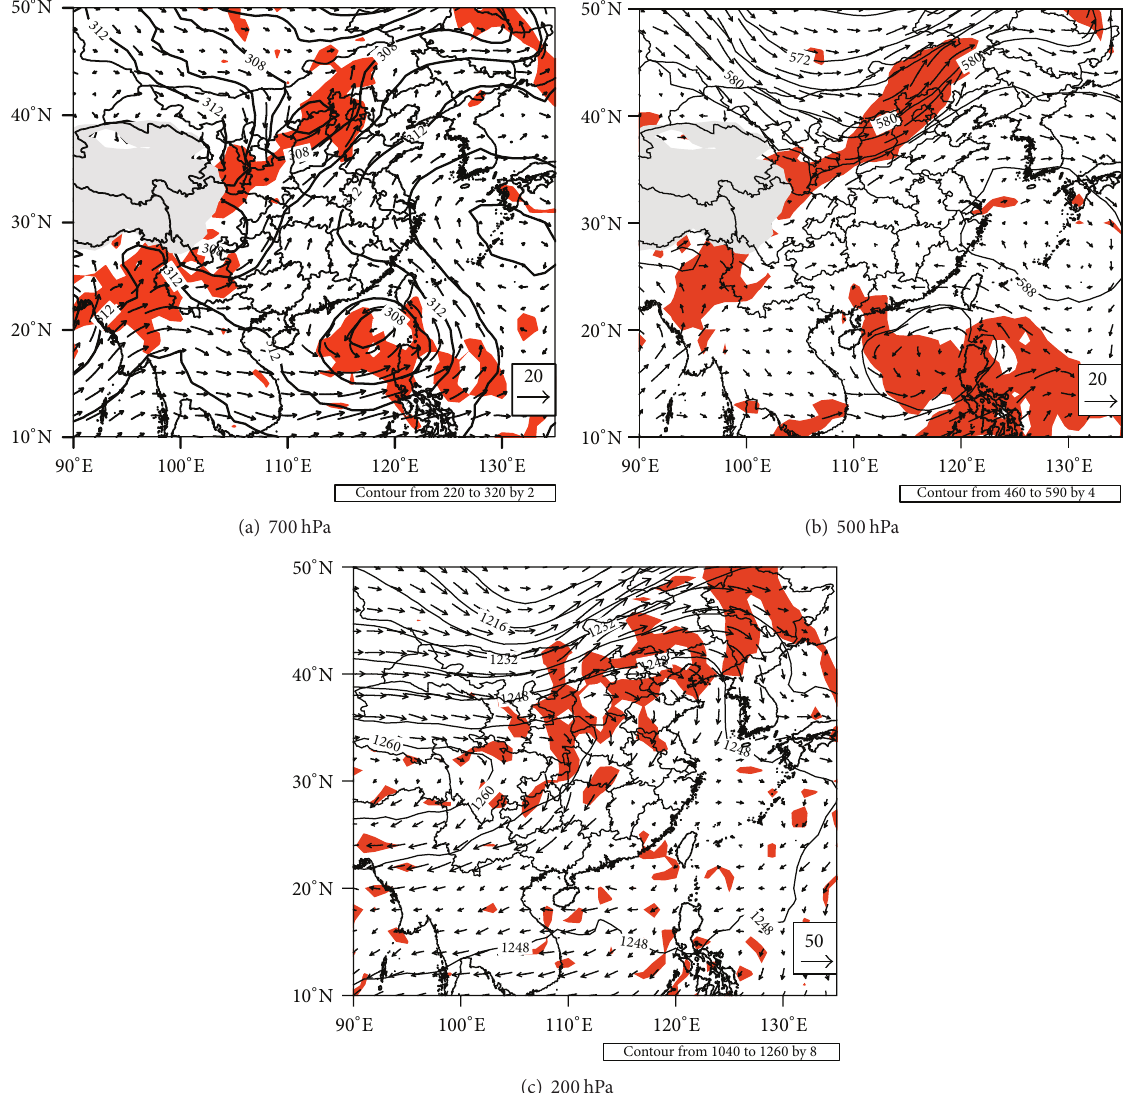
Figure 2: Geopotential height (solid) and wind barbs from the NCEP FNL analysis at 0600 UTC 21 July 2012 at (a) 700 hPa and (b) 500 hPa with the relative humidity exceeding 90% shaded, (c) 200 hPa with the horizontal divergence less than − 5 × 10 −5 s −1